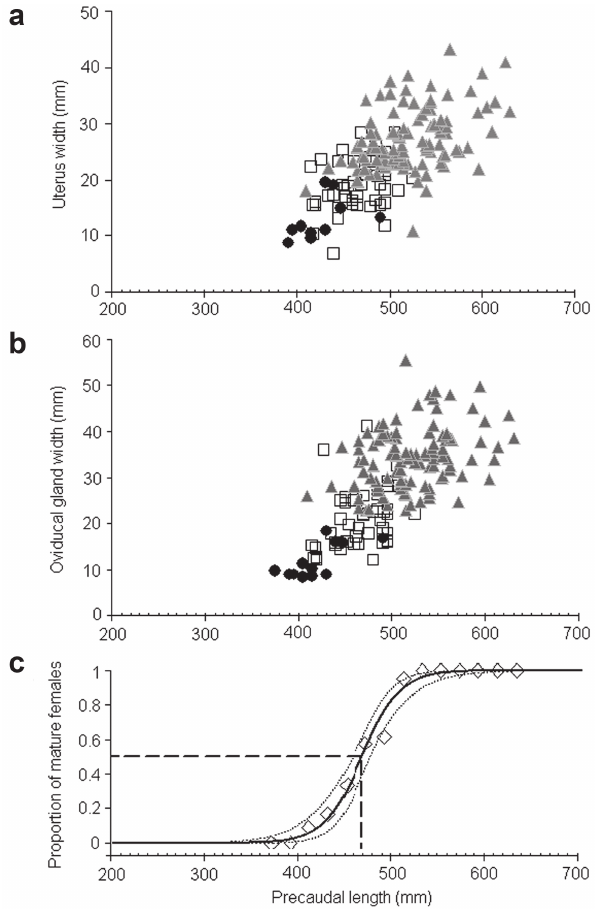
Fig. 5 . Relationships between precaudal length and a. uterus width and b. oviducal gland width of immature (black circles), maturing (white rectangles), and mature (grey triangles) Callorhinchus callorynchus females. c. Proportion of mature females in 20-mm precaudal length intervals, showing the logistic ogive fitted (black line) to the observed values (white diamonds) and the 95% confidence intervals (dotted lines). Long-dashed lines represent the size at 50% maturity.